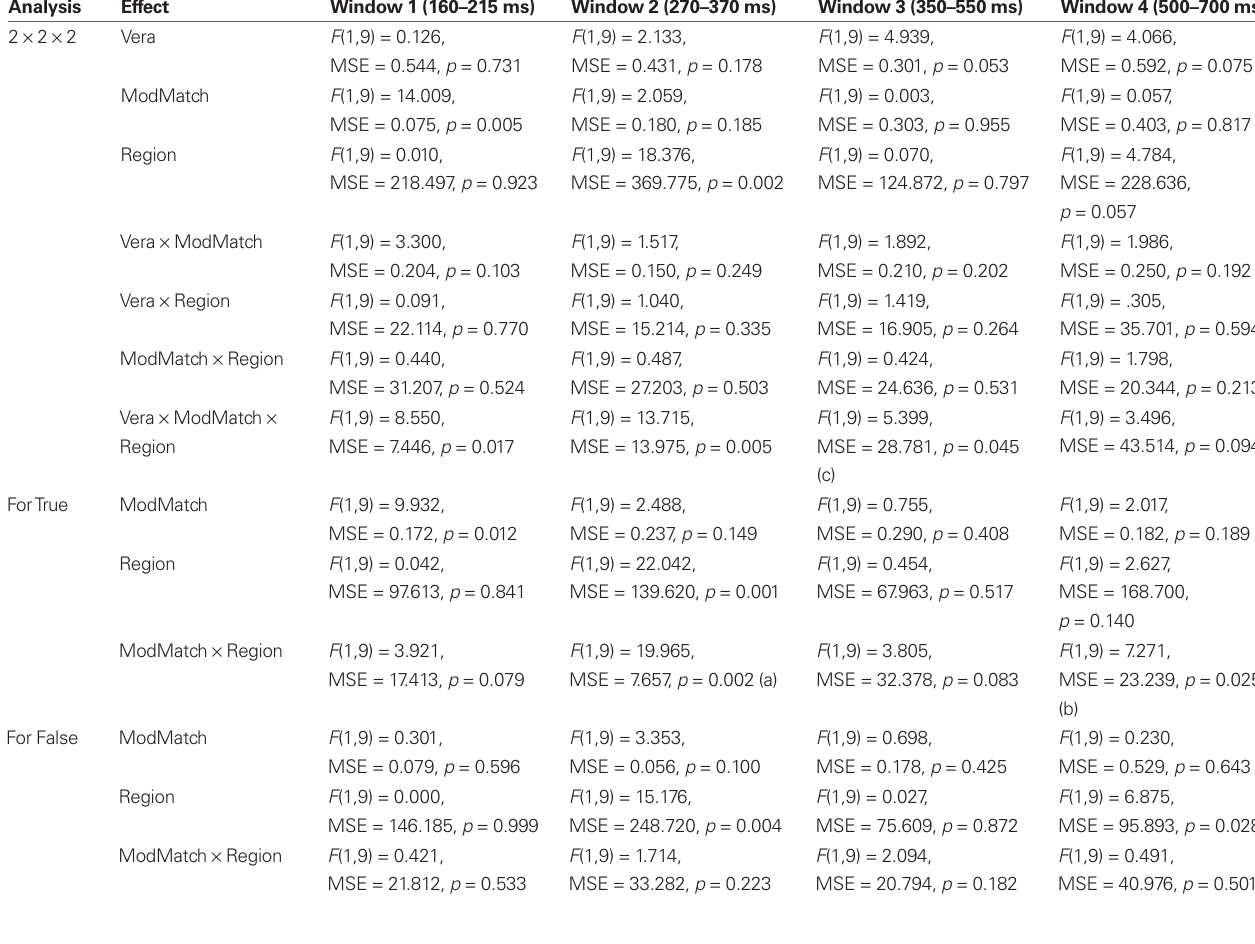
Table a1 | Full results of the Veracity × ModMatch × Region analysis for each window, with follow-up analyses for the results of ModMatch × Region within levels of